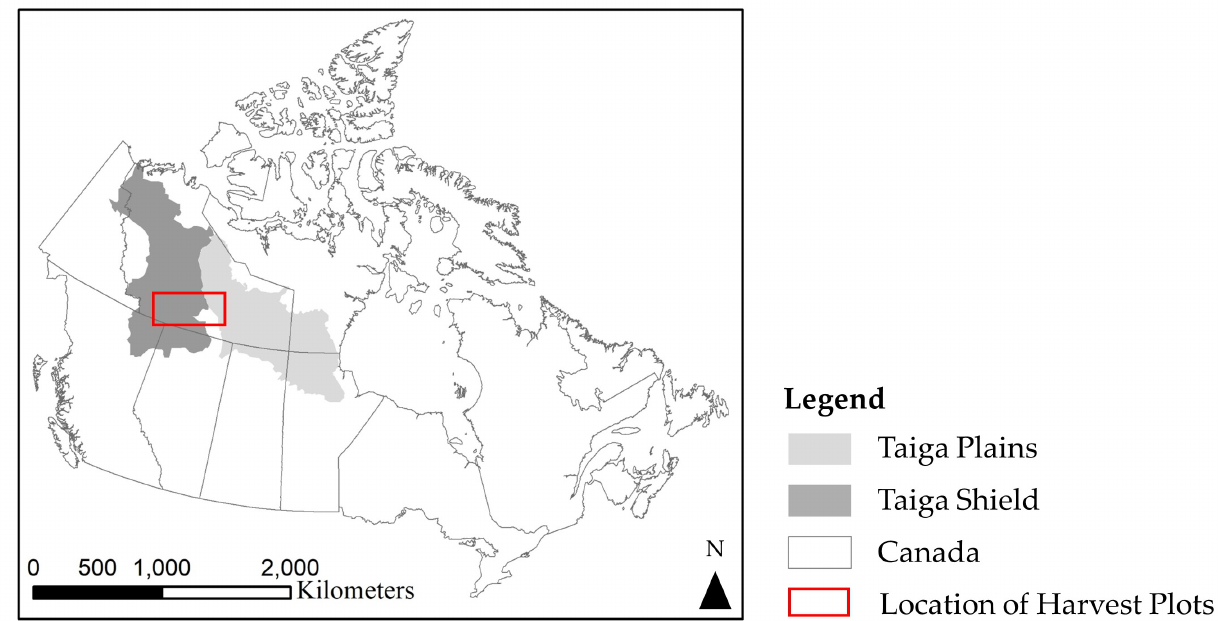
Figure 1. Area of harvested aboveground biomass of shrubs and trees, distributed across the sporadic to discontinuous permafrost zone of the Taiga Plains and Taiga Shield ecozones of boreal northwestern